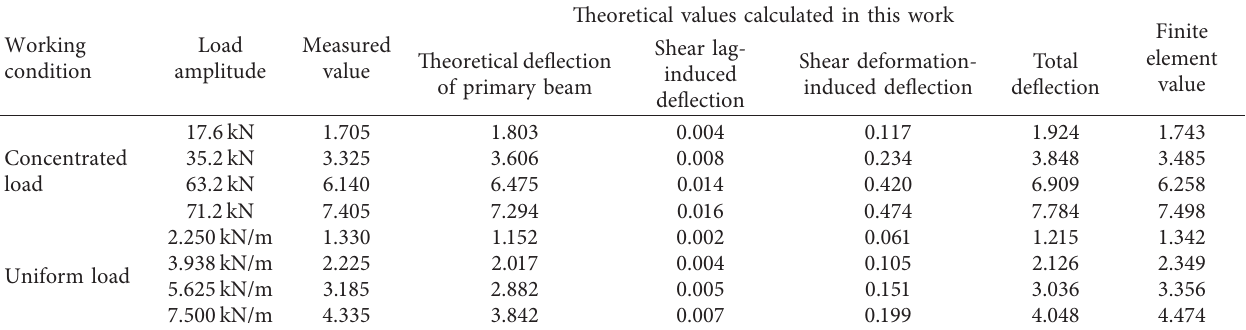
Finite element valueTheoretical deflection